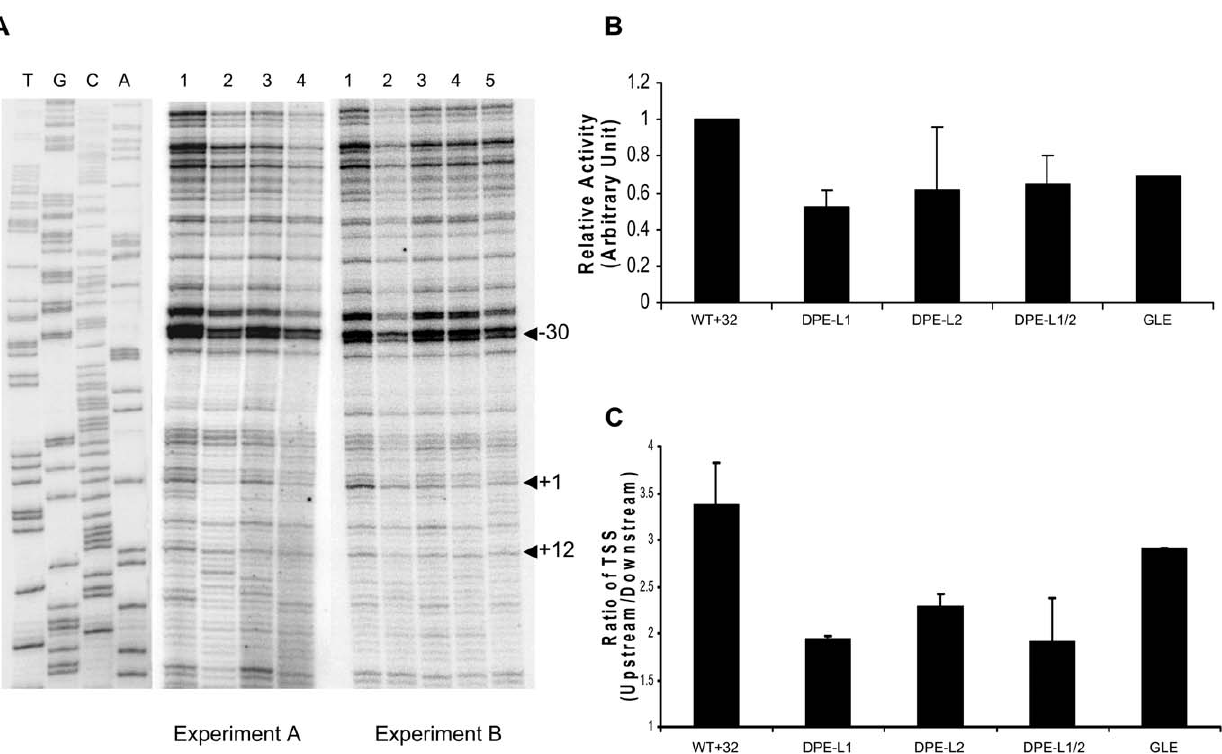
Figure 4. Downstream element mutations affect MHC class I promoter activity inVitro . A) Mutation of the downstream elements decreases MHC class I promoter activity invitro . In vitro transcription assays were performed with HeLa nuclear extract and a DNA template consisting of the MHC class I promoter fused to the CAT reporter gene which extended from 2 416 bp of the class I promoter to the junction with the CAT gene at + 32, and continued another 68 bp into the CAT gene. RNA product was assessed by primer extension. DNA sequence ladder is shown on the left. (1) WT + 32 wild type promoter; (2) DPE-L1; (3) DPE-L2; (4) DPE-L1/2; (5) GLE (See schematic in Figure 3A). Specific transcription initiation occurs at multiple sites both in vivo and in vitro [44]. Experiment A and B refer to two independent, replicate experiments. B) Mutation of the downstream elements reduces promoter activity. The promoter strength of the wild type, GLE, DPE-L1, DPE-L2, and DPE-L1/2 constructs was analyzed by densitometry of total TSS ( 2 42 bp to + 31 bp) to compare total activity of promoter in each construct. C) Downstream elements preferentially regulate transcription start sites in the upstream region of the promoter. Analyses of relative transcription start site usage by the wild type, GLE, DPE-L1, DPE-L2, and DPE-L1/2 were done by densitometric quantitation, calculating the ratio between upstream TSS ( 2 42 bp to + 2 bp)and downstream TSS ( + 3 bp to + 32 bp). This experiment is representative of two independent experiments.